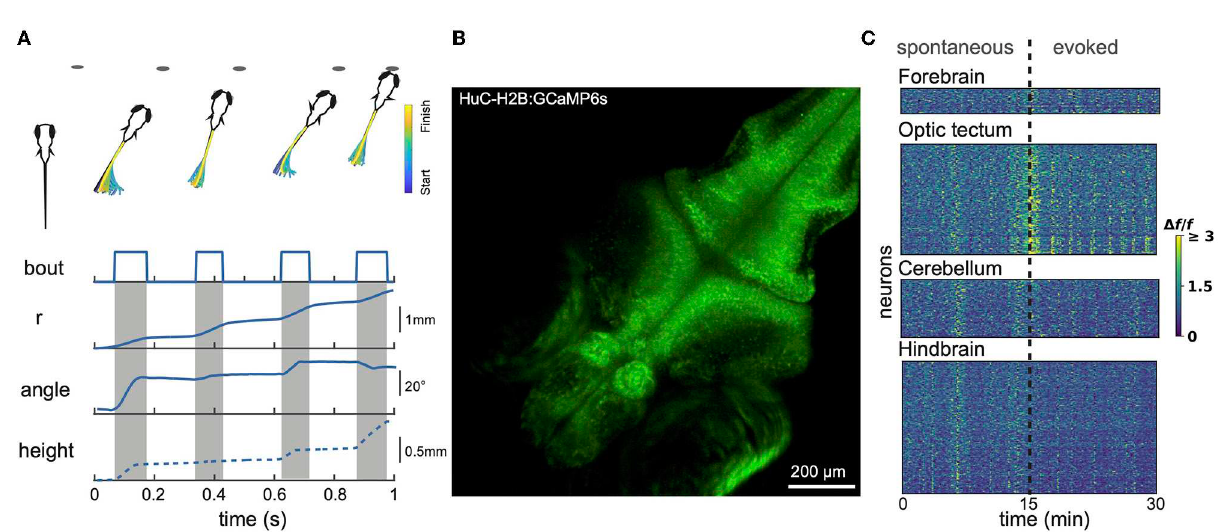
FIGURE1 Larval zebrafish behavior and neural activity imaging. (A) Example hunting sequence. Also shown are total displacement (r), heading angle and z-depth (height). r and angle data were recorded in 2D for the hunting event shown above; height data was estimated based on data from similar events recorded in 3D by others (Bolton et al., 2019). (B) Example maximum projection image of volumetric 1-photon light sheet recording of a GCaMP6s 9 dpf fish imaged at 1 Hz. 15 planes were captured spanning a total z-range of 150 µ m. (C) Calcium signals measured using light sheet recording during spontaneous activity and in response to presentation of prey-like stimuli. Different brain regions captured simultaneously show both synchronized and region-specific activity